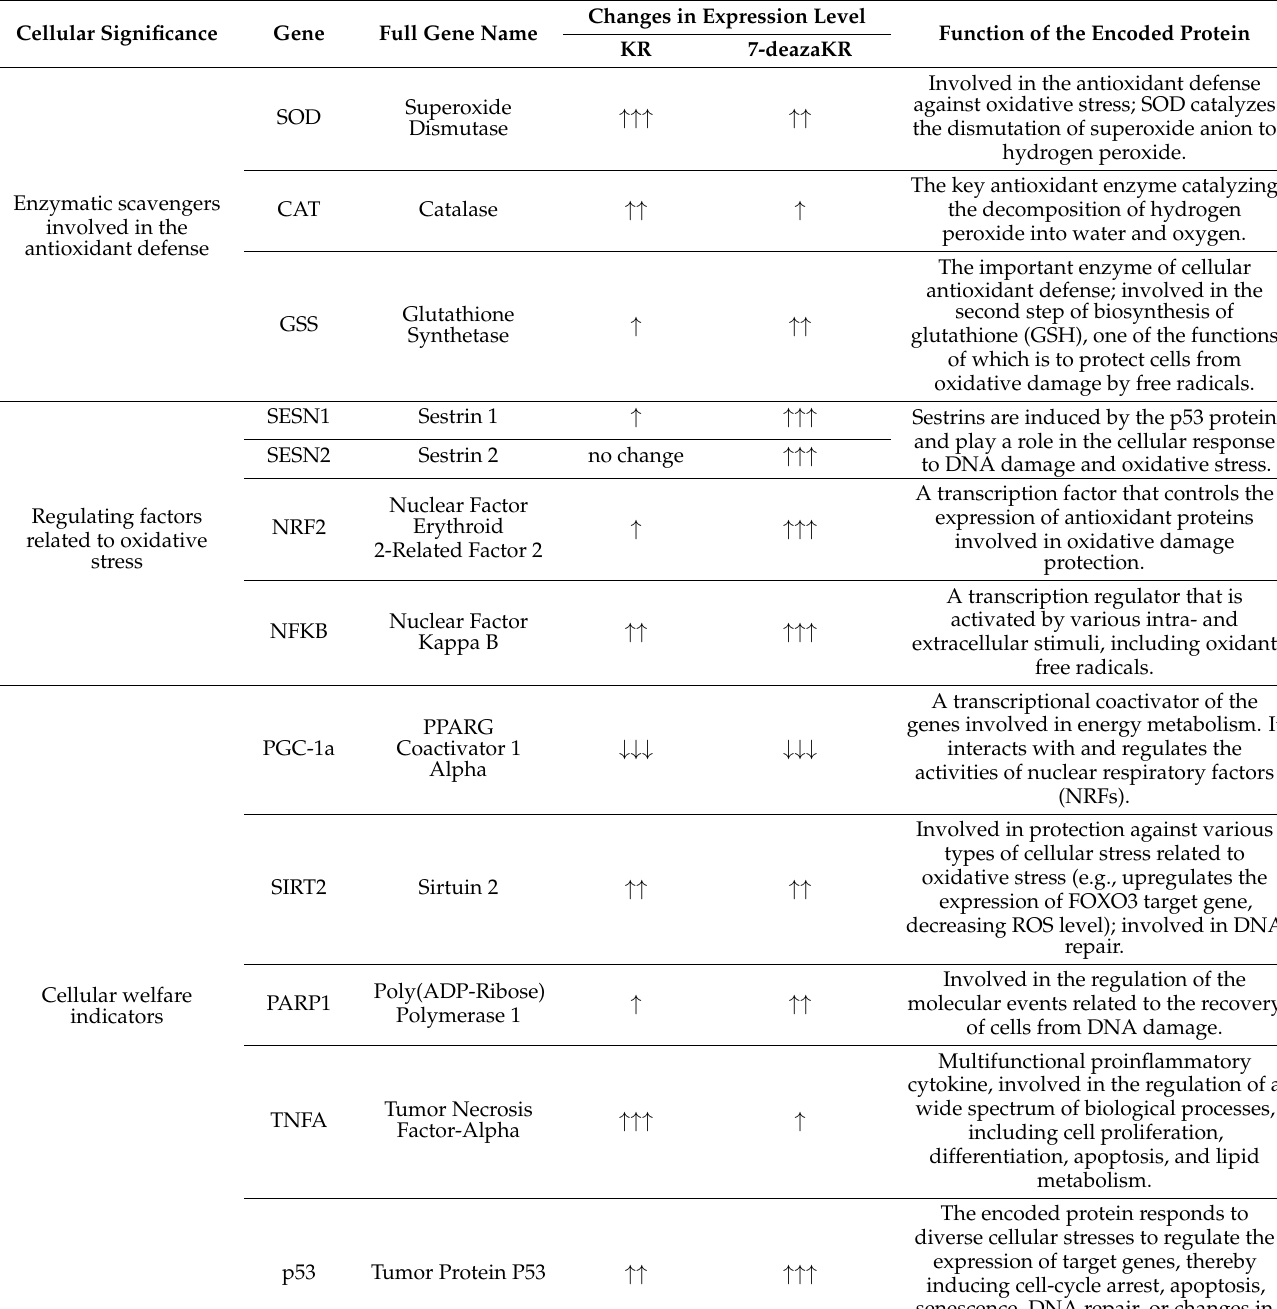
Table 2. Summary of changes in the expression level of genes analyzed by real-time PCR, including the function/action of the encoded protein, as well as their implication/entanglement in the main cellular processes. Up arrow (up-expression); Down arrow (down-expression), number of arrows correlates with the strength of expression